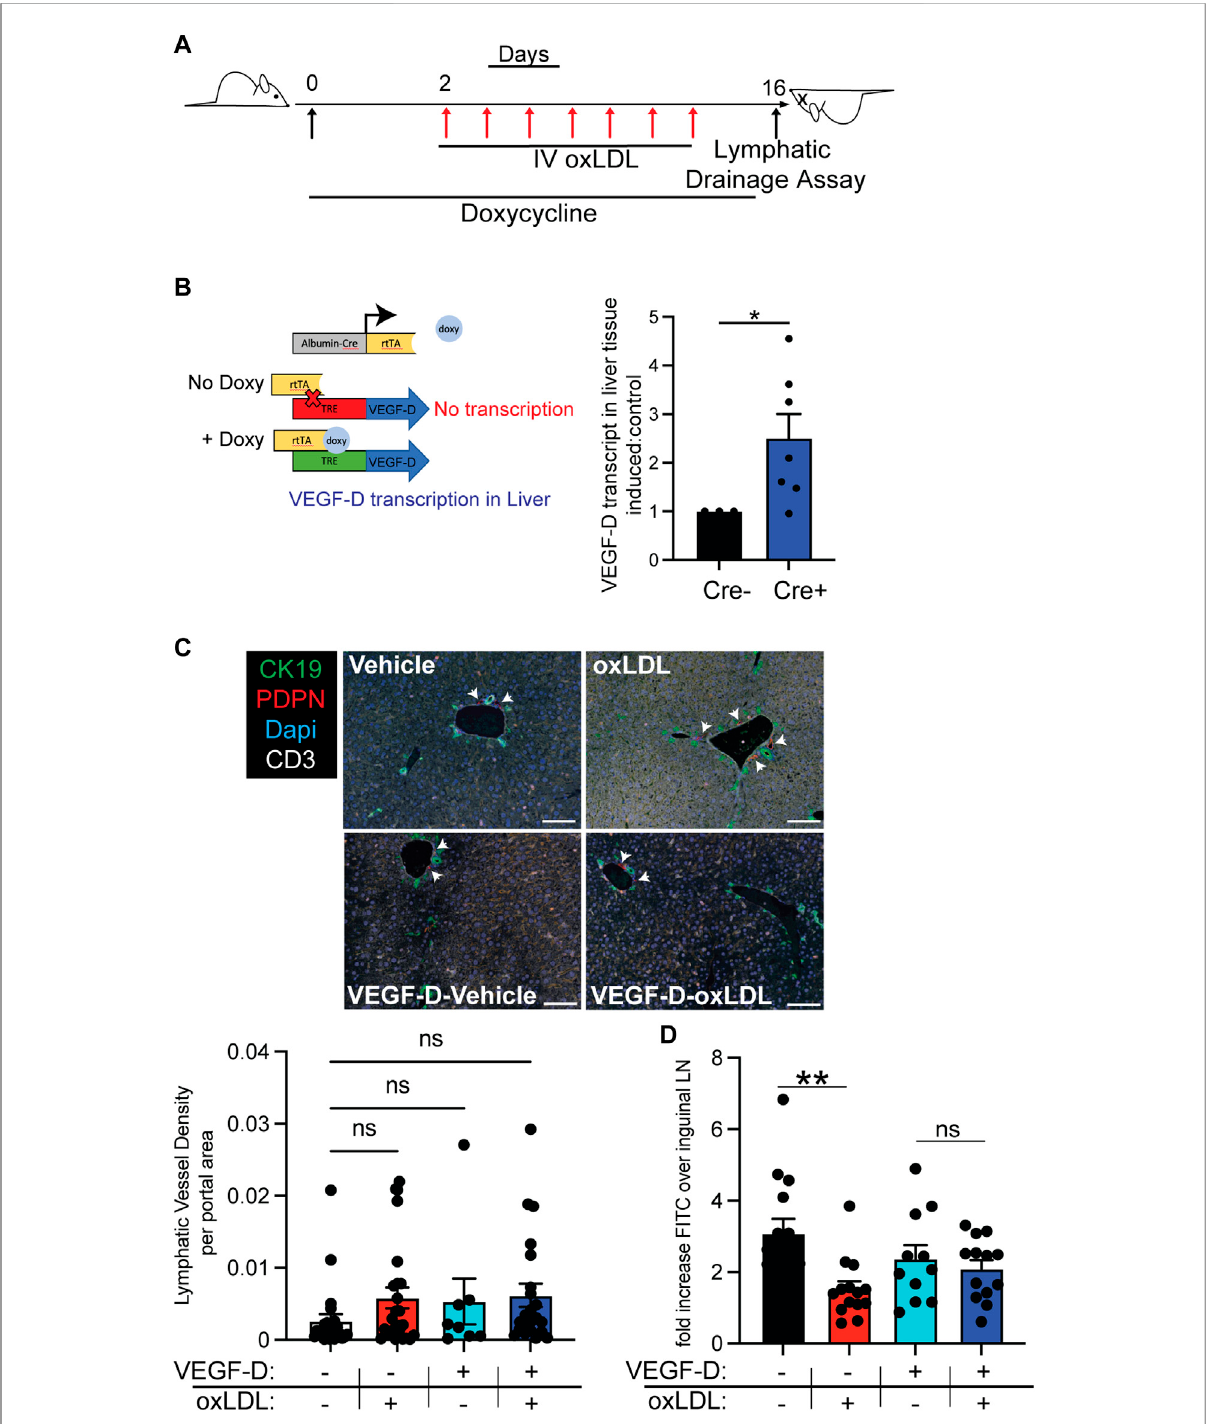
FIGURE 4 VEGF-DimprovesoxLDLinducedlymphaticdysfunction invivo. (A) ExperimentaldesignofFITC-dextranassay(asdescribedinFigure1),VEGF- D expression was induced with doxycycline 48 h and continued during 2-week duration of every other day oxLDL injection with last injection 48 h priorto harvest. (B) GeneticmodelofTRE-VEGF-DxAlbumin-Cre promotorrtTAmicedevelopedfor hepatocyte-speci fi cactivationandexpression ofexcessVEGF-D.TranscriptlevelsofVEGF-Dexpressioninwholelivertissueofcontrolmice(cre-)comparedtoVEGF-Dinducedmice(cre+) expressed as fold change from expression level of Cre-mice. Shown is a representative experiment. Experiment was performed 3 times with similar results. (C) Lymphatic vessel density as imaged with Perkin Elmer Vectra fl uorescent microscope. Bile ducts [CK19 + PDPN+(green)], lymphatics [CK19-PDPN+ (red)] (highlighted with white arrows), T cells [CD3 (white)] and nuclear [Dapi (blue)] were stained and lymphatic vessel density was